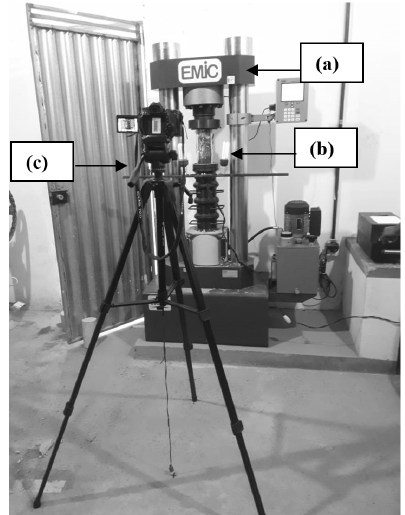
Figure 2: Assembly of the DIC-2D System a) load application system b) UV lamps c) a sensor digital camera